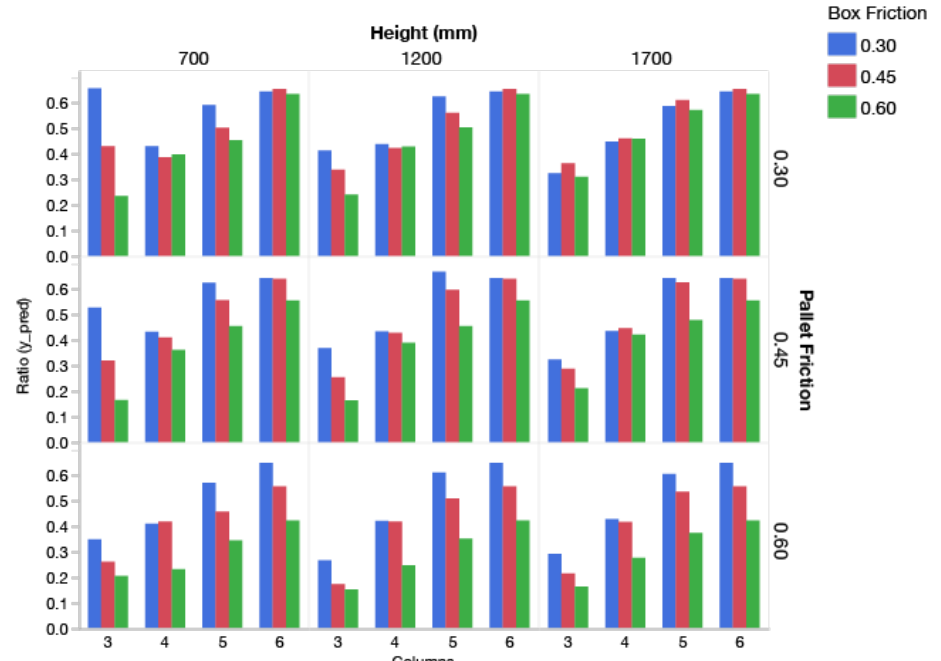
Figure 9. Effect of number of columns on board bending ratio by height (mm), box friction and pallet friction coefficients.